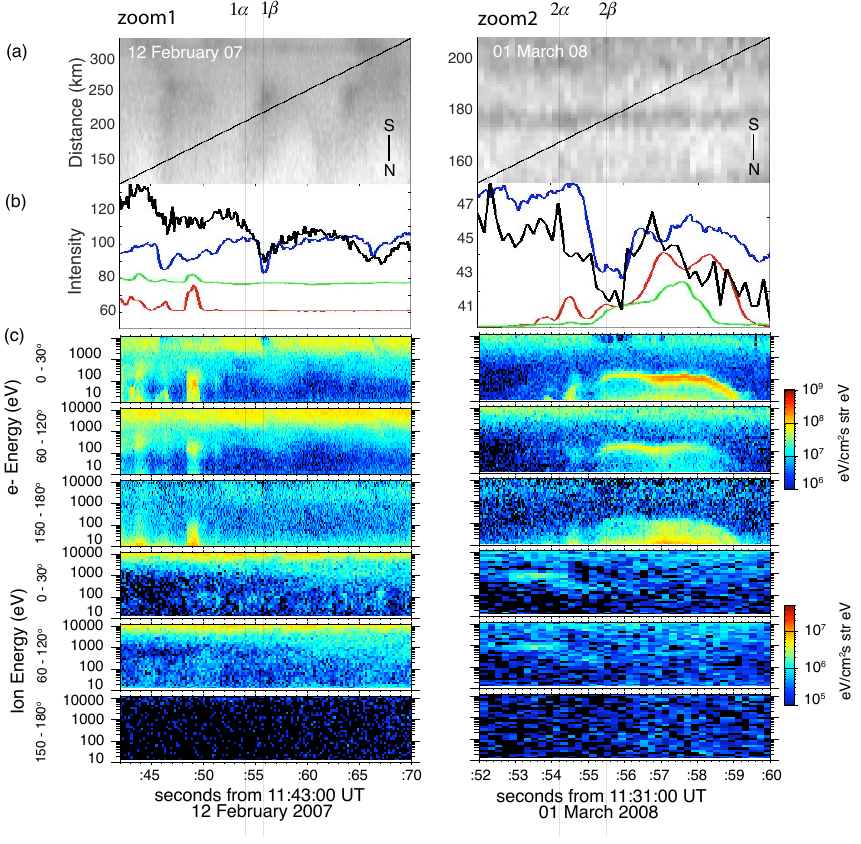
Fig. 4. Same format as Fig. 2, but showing two shorter time periods on 12 February 2007, starting at 11:43:42UTC (left panel) and 1 March 2008, starting at 11:31:52UTC (right panel). Four specific times are noted, 1 α , 1 β , 2 α , and 2 β , which are the times examined in more detail in Fig. 6.